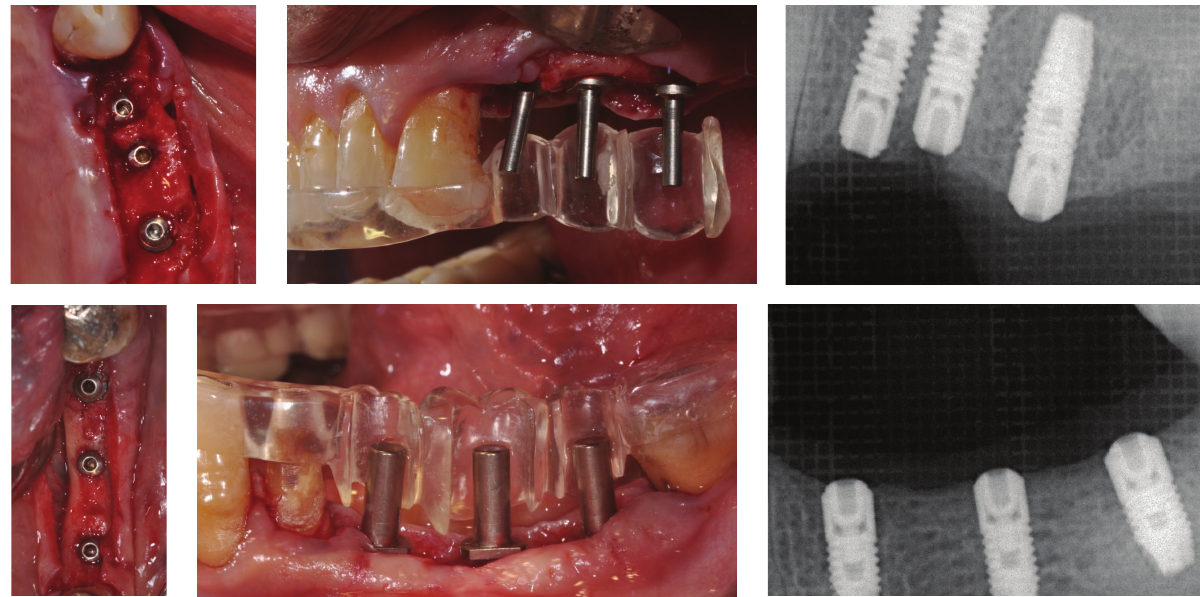
Figure 4: Type 3 prosthetically guided implant positioning, surgical and radiographic view.